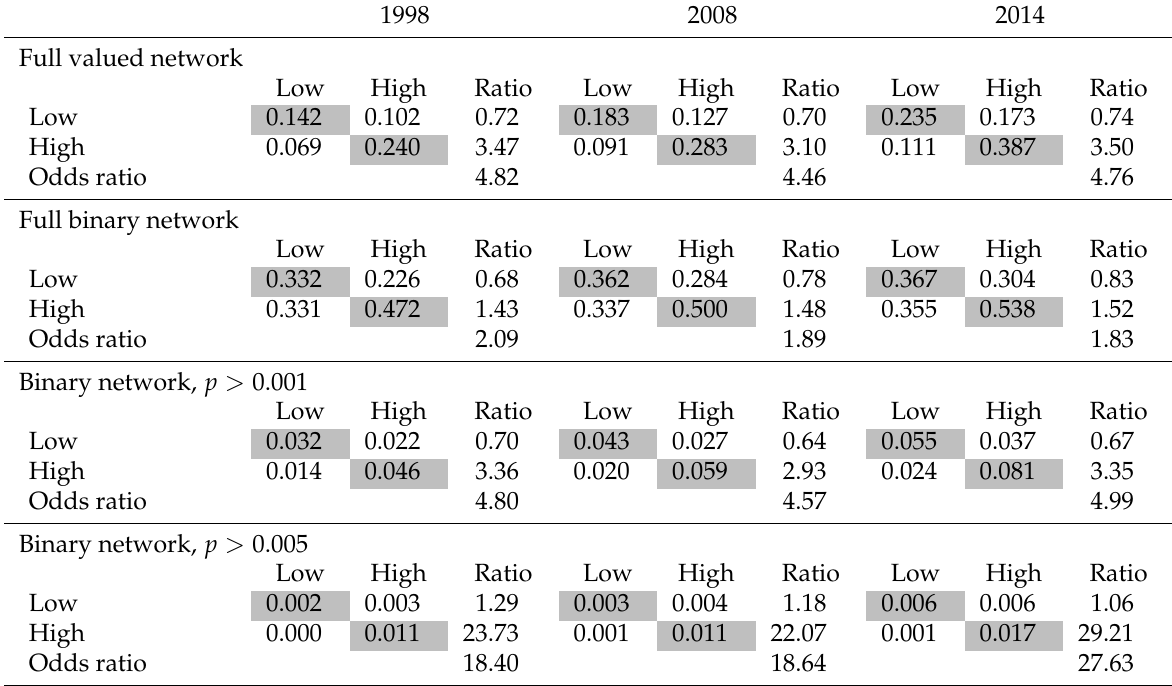
Table 3: Density of ties between and within occupational status categories, 1998 to